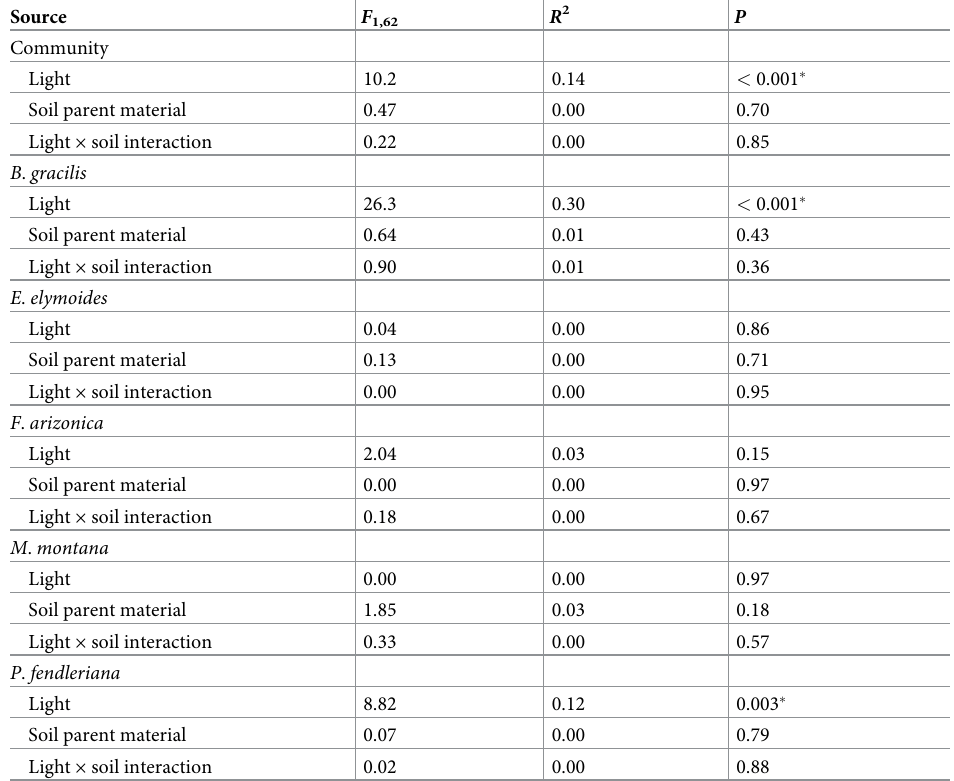
Table 2. Results from a two-way PerMANOVA with light (sun, shade), parent material (basalt, limestone), and their interaction as factors influencing the resulting species abundances in the